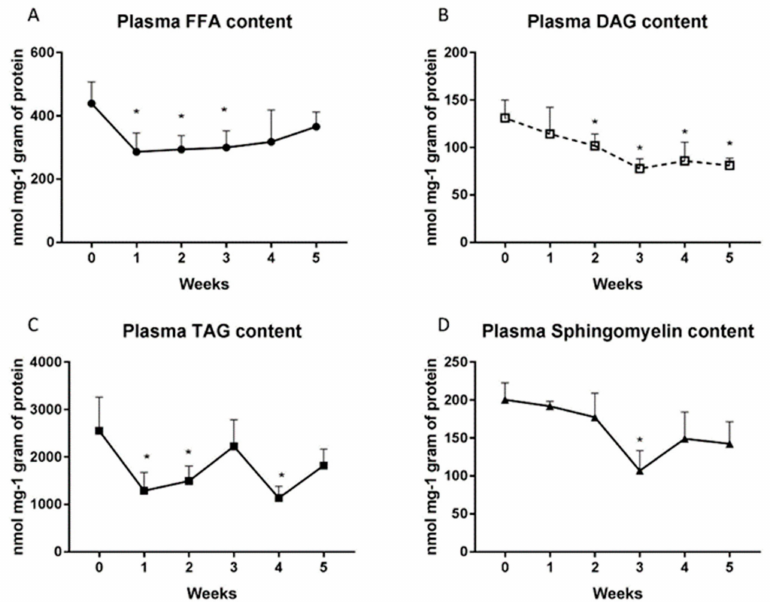
Figure 2. Plasma contents of free fatty acids ( A ), diacylglycerols ( B ), triacylglycerols ( C ) and sphingomyelin ( D ) in control group (0 week) and HFD group at the end of each experimental week (1, 2, 3, 4 and 5). The plasma was prepared as described in detail in the ‘Materials and methods’ section. Total lipid content was measured by GLC method. The data are expressed as the mean ± S.D. and are based on six independent determinations ( n = 6). * p < 0.05 significant di ff erence vs control group (0